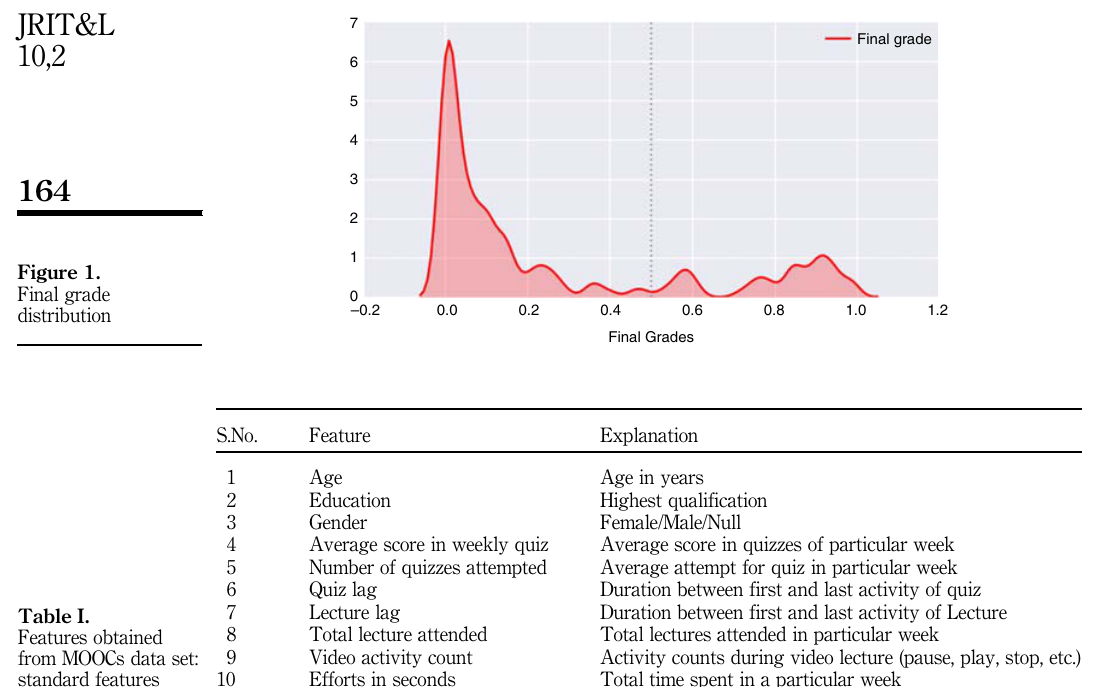
Table I. Features obtained from MOOCs data set: standard